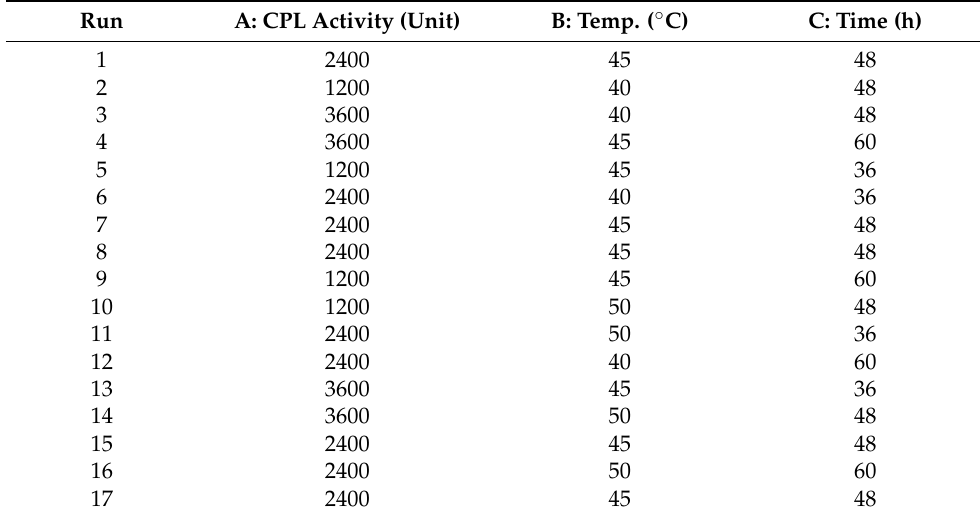
Table 1. Experimental run from the Box–Behnken design of the 3